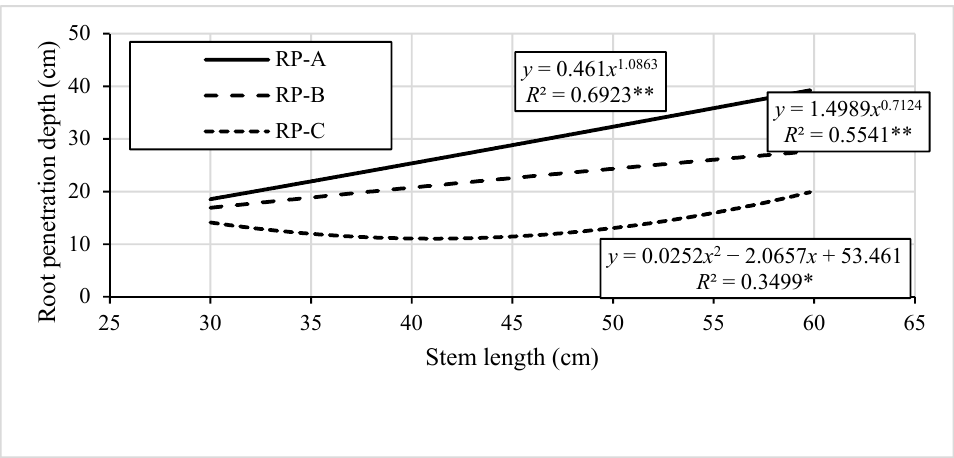
Figure 6. Relationship between stem length and main root penetration depth of maple seedlings in